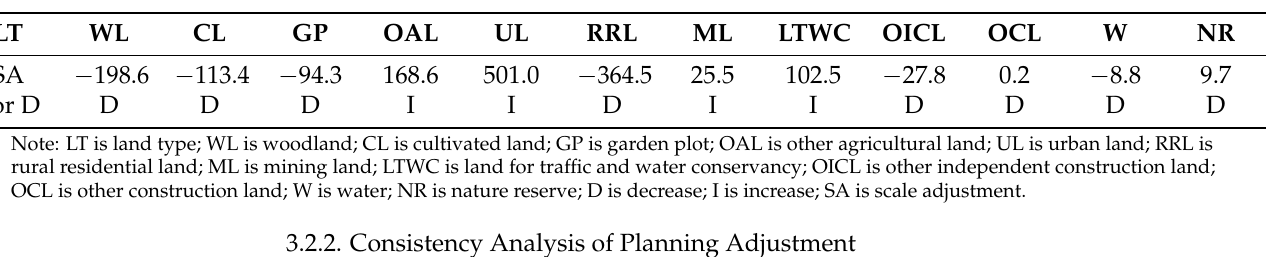
Table 6. Adjustment and change in general land-use planning in Rongchang District from 2013 to 2015.